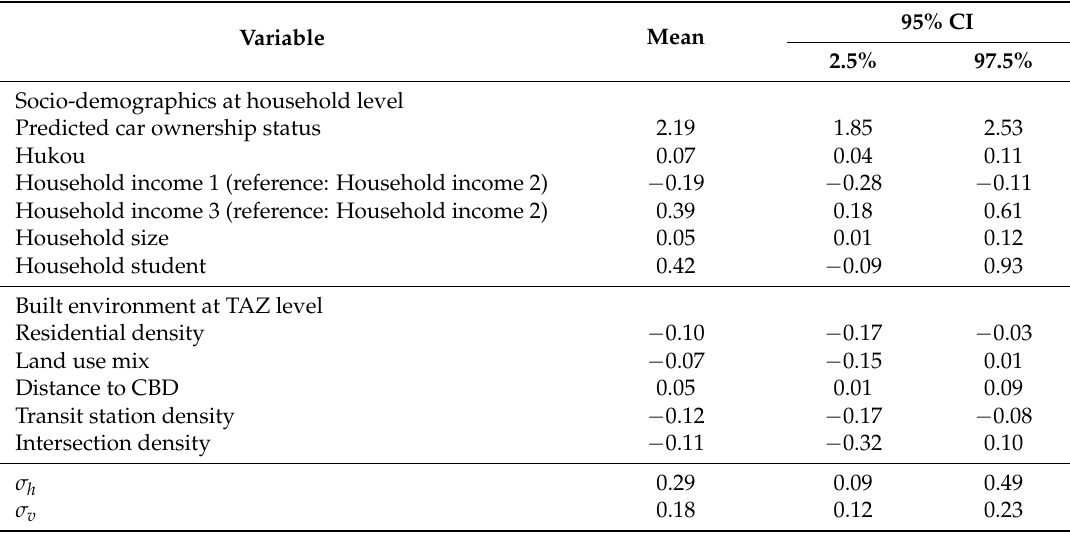
Table 4. Multilevel Bayesian Normal regression of household VKT (vehicle kilometers traveled).